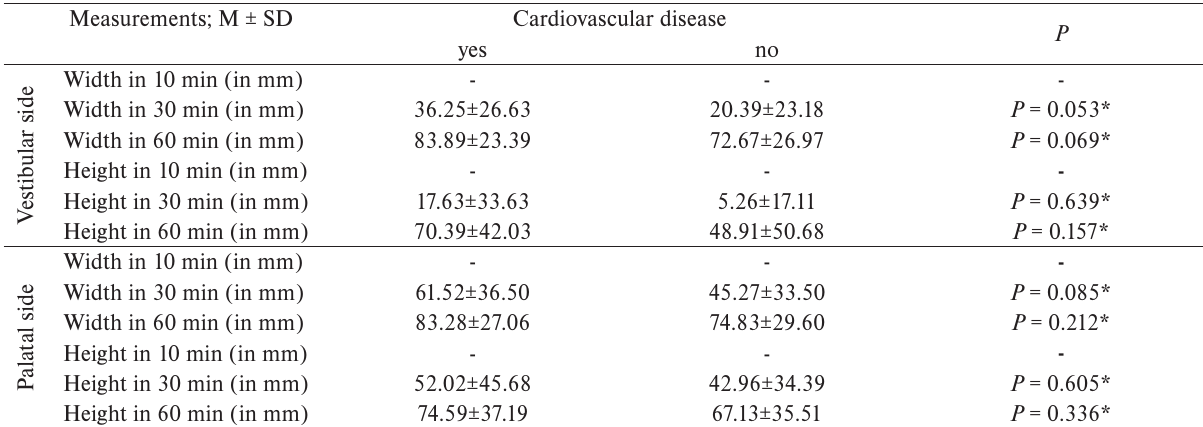
Table 5. Percentage of the decrease of anesthetic area in both groups depending on the first